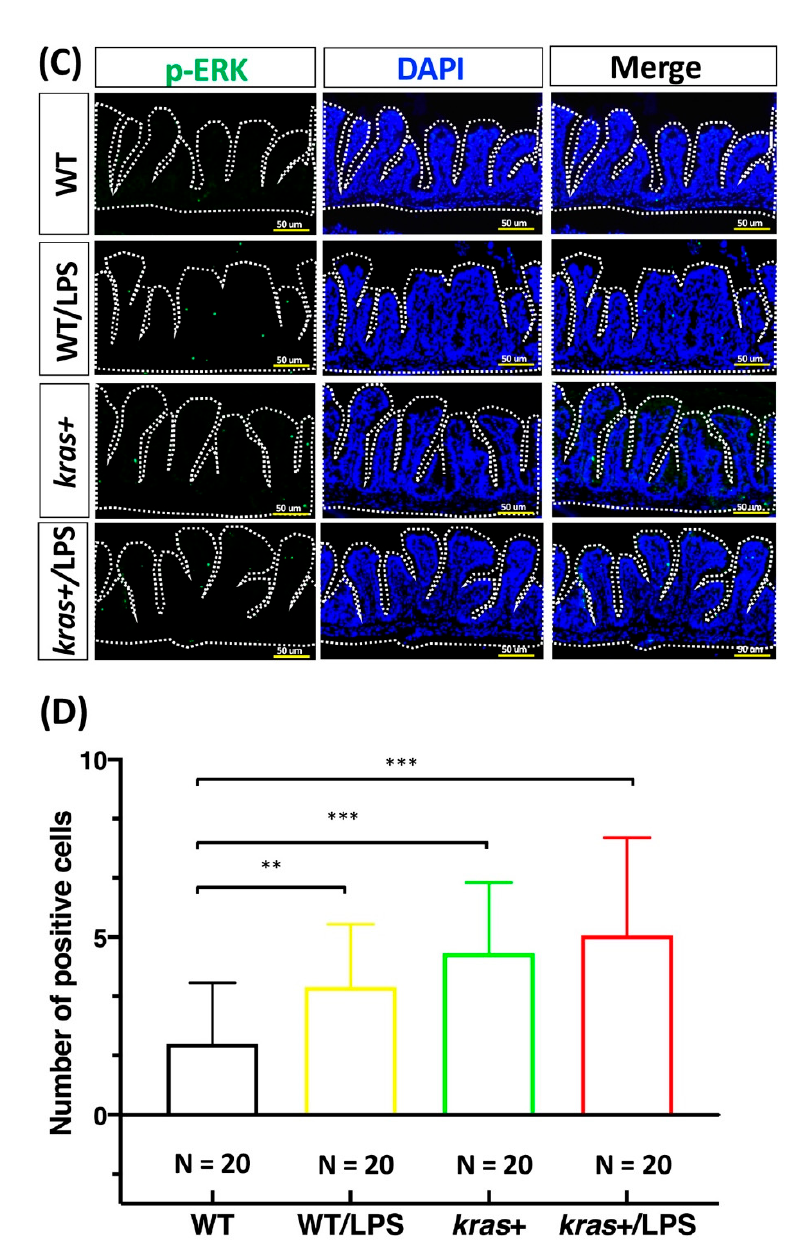
Figure 5. Expression of kras V 12 with LPS treatment enhanced the increase in p -AKT in intestinal epithelial cells. ( A , C ) Immunofluorescence staining (red) was performed on intestinal paraffin sections of WT (N = 20), WT/LPS (N = 20), kras+ (N = 20), and kras+/LPS (N = 20) zebrafish. ( B , D ) Immunofluorescence staining of p -AKT and p -ERK as a marker of RAS signaling and quantification of the number of positive cells. Differences among the variables were assessed using Student’s t-tests. Statistical significance: * p < 0.05, ** p < 0.01, *** p < 0.001. Scale bar: 50 μ m.